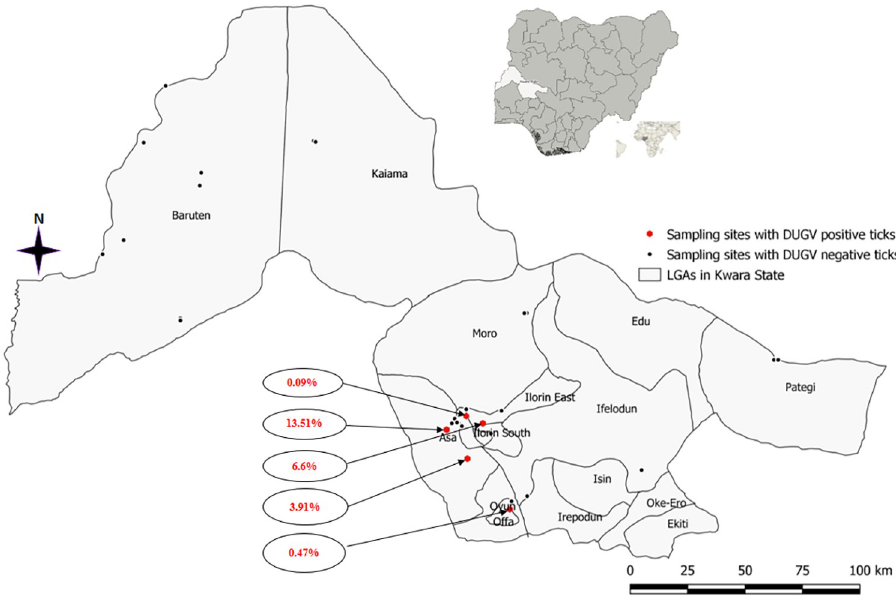
Fig 1. Map of Kwara State of Nigeria showing sampling sites. DUGV-positive sites in red and DUGV-negative sites in black circles. Values in red colour indicate DUGV detection rates at individual sampling sites based on RT-qPCR. The base layer of the map was created using DIVA-GIS Version 7.5 (https://www.diva-gis.org/) software. https://doi.org/10.1371/journal.pntd.0009905.g001 Five out of the 31 sampling sites (located in four of the 10 LGAs selected) had DUGV-posi- tive ticks and DUGV presence ranged from 0.09–13.51% (Fig 1; Table 3). Further, the results indicate that DUGV was detected at two sampling sites at Asa LGA (A: 15/111, 13.5%; B: 9/ 230, 3.9%) (Fig 1). Other LGAs where DUGV-positive ticks were detected include Ilorin East (7/1,716; 0.4%), Offa (2/423; 0.5%) and Ilorin West (1/696; 0.1%) (Fig 2). Based on the ticks selected for DUGV detection, the result showed that more DUGV-posi- tive A . variegatum were found during the dry (23/904; 2.54%) than the rainy (9/1,397; 0.64%)